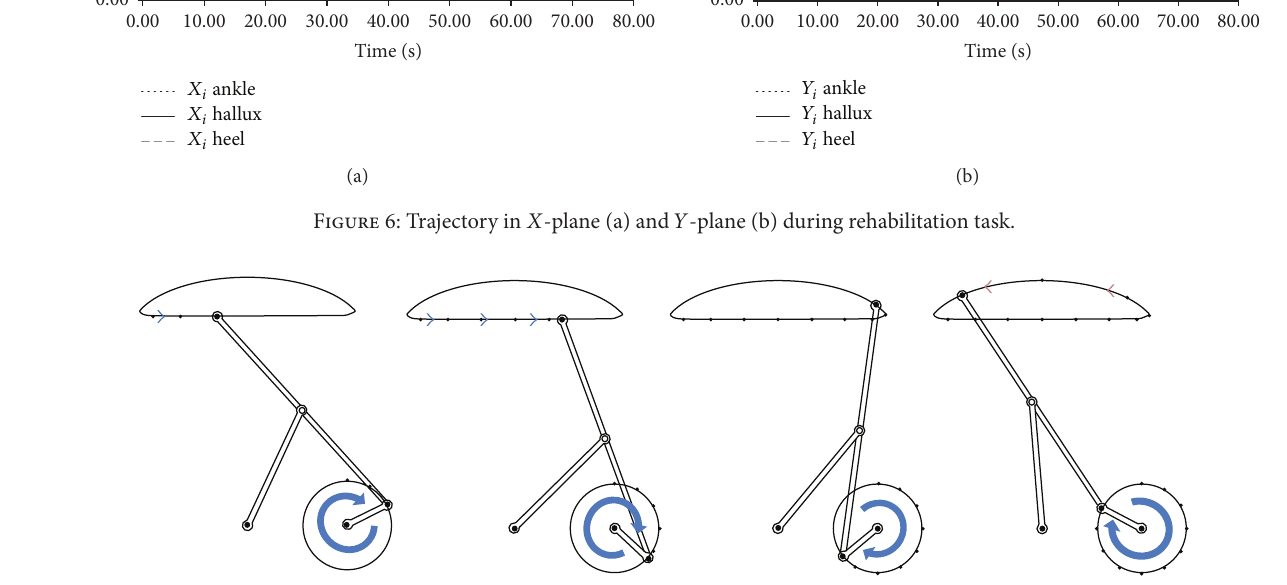
Figure 7: Noneccentric crank with single degree of freedom.